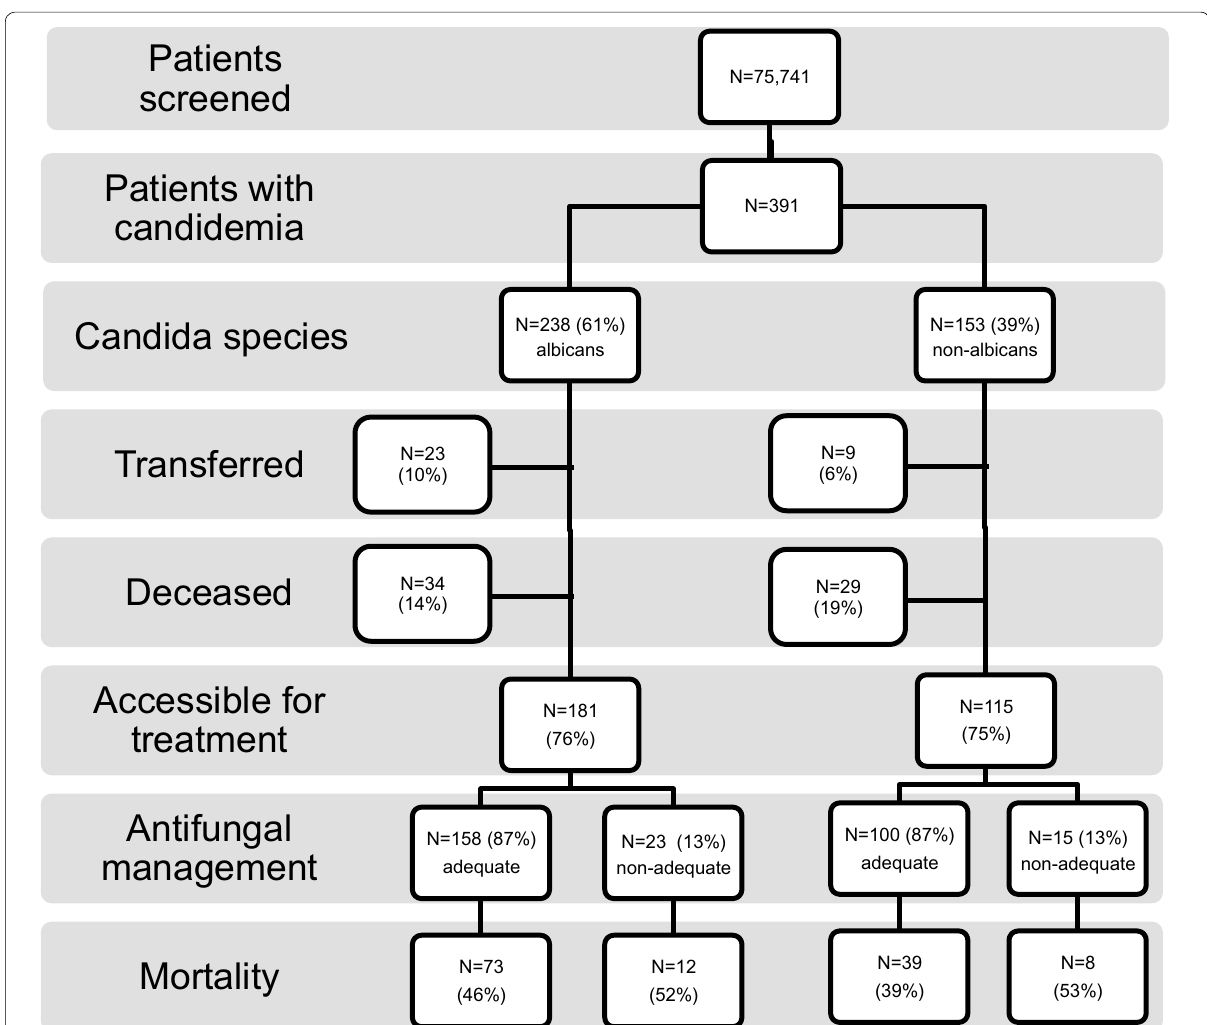
Fig. 1 Flow of participants throughout the study. “Accessible for antifungal treatment” refers to patients, who were not transferred or died prior to diagnosis of bloodstream infection caused by Candida